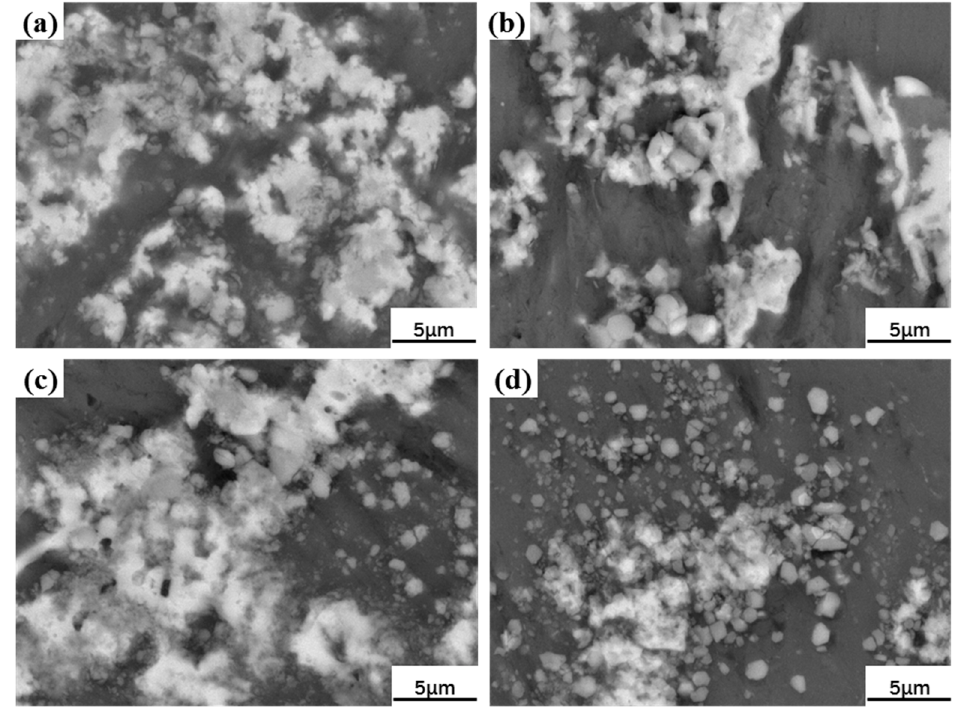
Figure 4. Microstructures of sub ‐ micrometer particle agglomerations in composites with different UVT time: ( a ) 0 s, ( b ) 30 s, ( c ) 60 s and ( d ) 120 s. Metals 2019 , 9 , x FOR PEER REVIEW